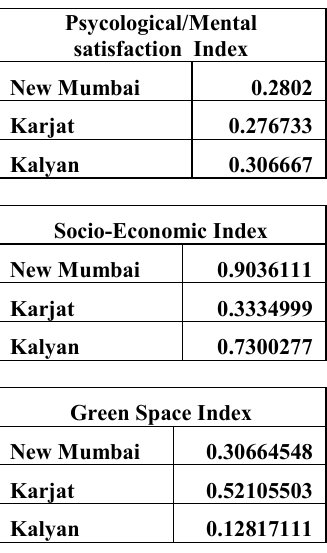
Table 1 : Composite indices